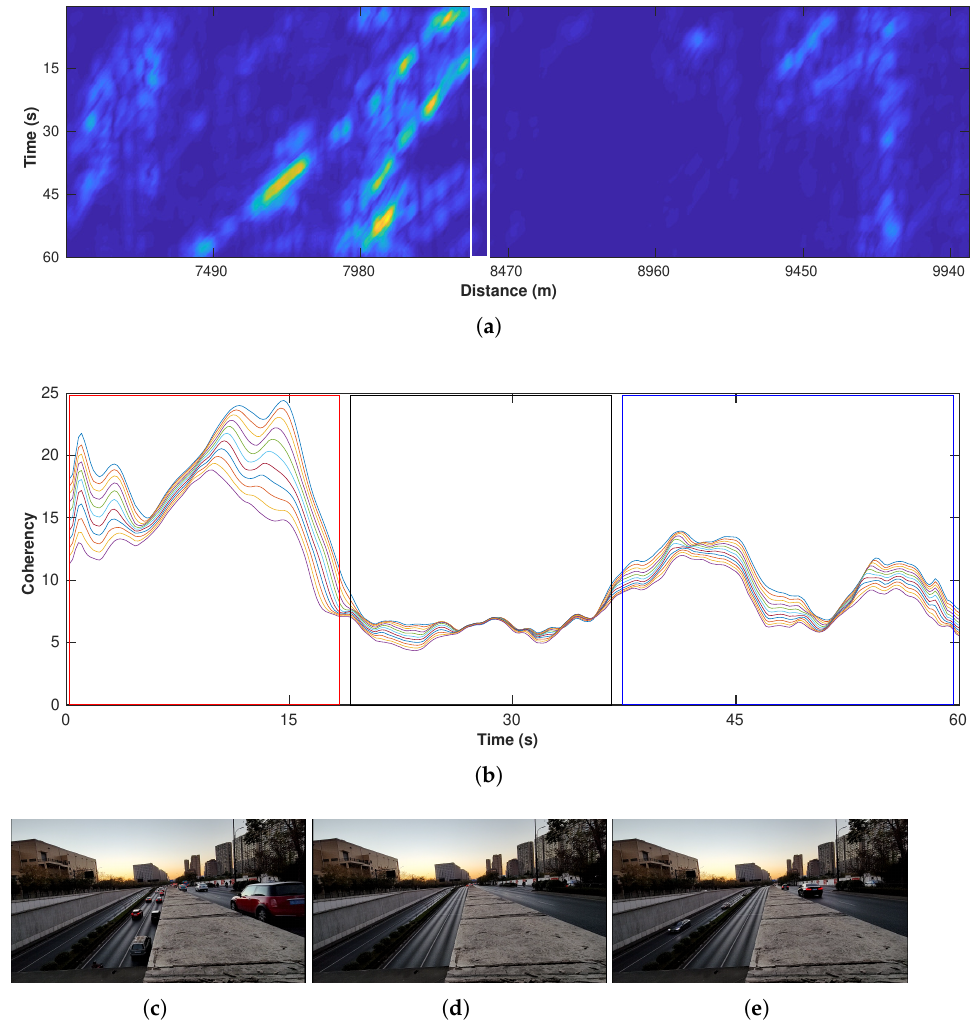
Figure 17. An example of traffic volume monitoring. ( a ) A 2D map of a one-minute correlation-based attribute. The white rectangle indicates the location of the 11 channels shown in ( b ). ( b ) The coherency values of selected channels near the camera. The red, black, and blue rectangles highlight the time periods with ( c ) many cars, ( d ) no cars, and ( e ) a few cars,